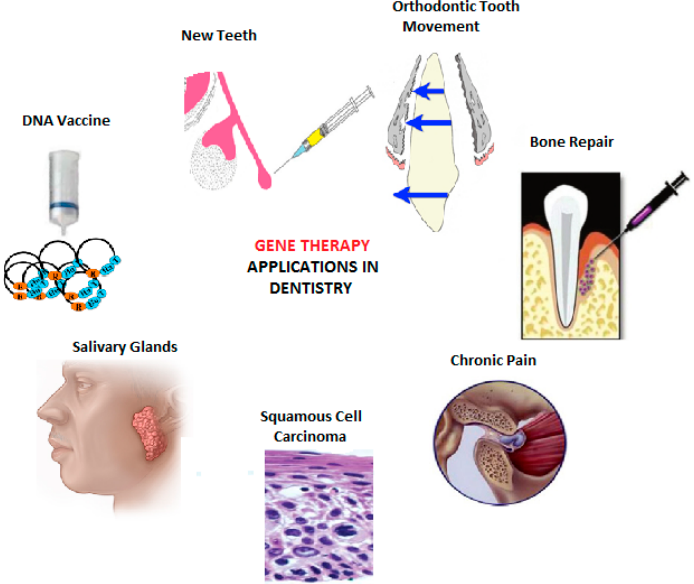
Figure 2. Current and potential applications of gene therapy in the field of